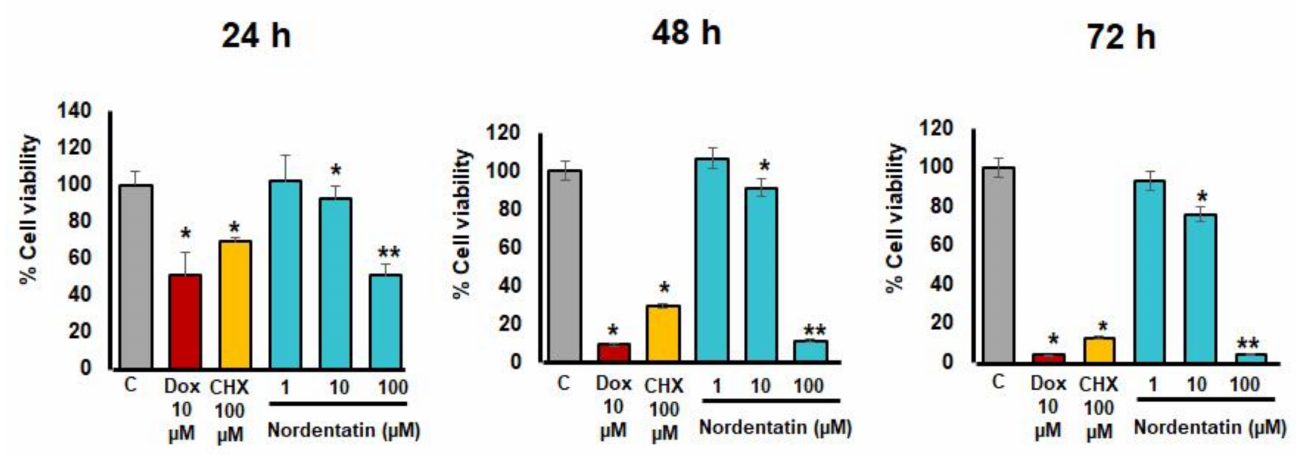
Figure 1. The percentage of neuroblastoma (SH-SY5Y) cells that survived after being exposed to the nordentatin at various concentrations for 24, 48, and 72 h, compared to cells exposed to standardized doxorubicin (Dox) and cycloheximide (CHX). The experiments were conducted in triplicate. * p < 0.05, ** p < 0.01 versus control